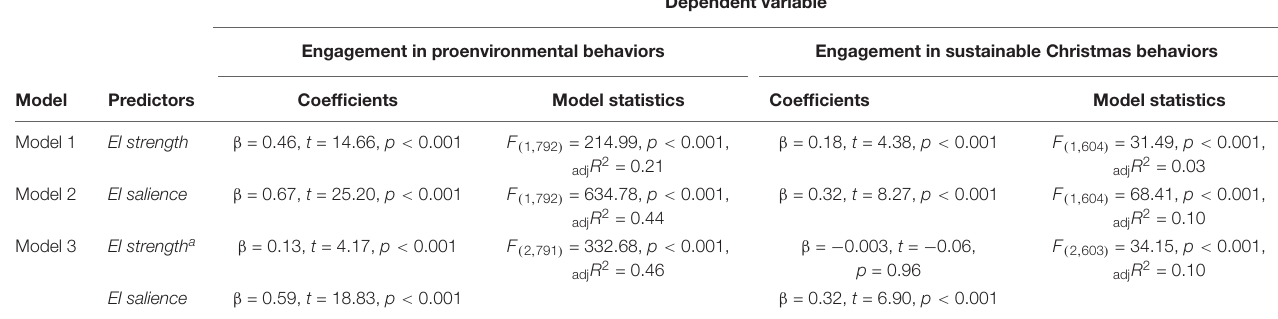
TABLE 7 | Linear regression models (Study